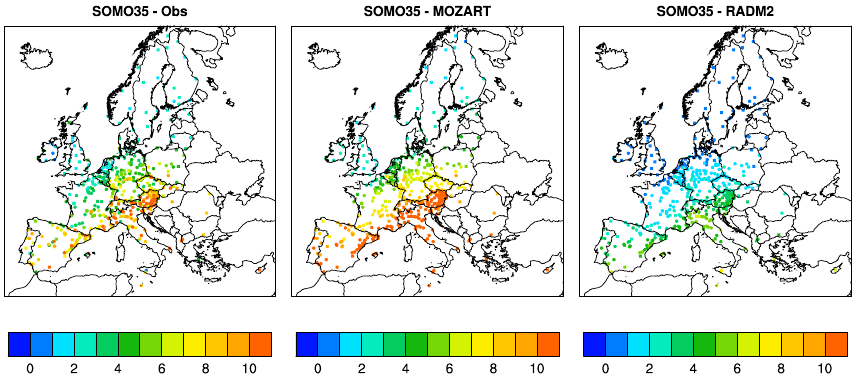
Figure 8. Yearly values of SOMO35 in mgm − 3 multiplied by days calculated from hourly measurements at AirBase (circles) and EMEP (squares) stations, and modeled values for corresponding locations.